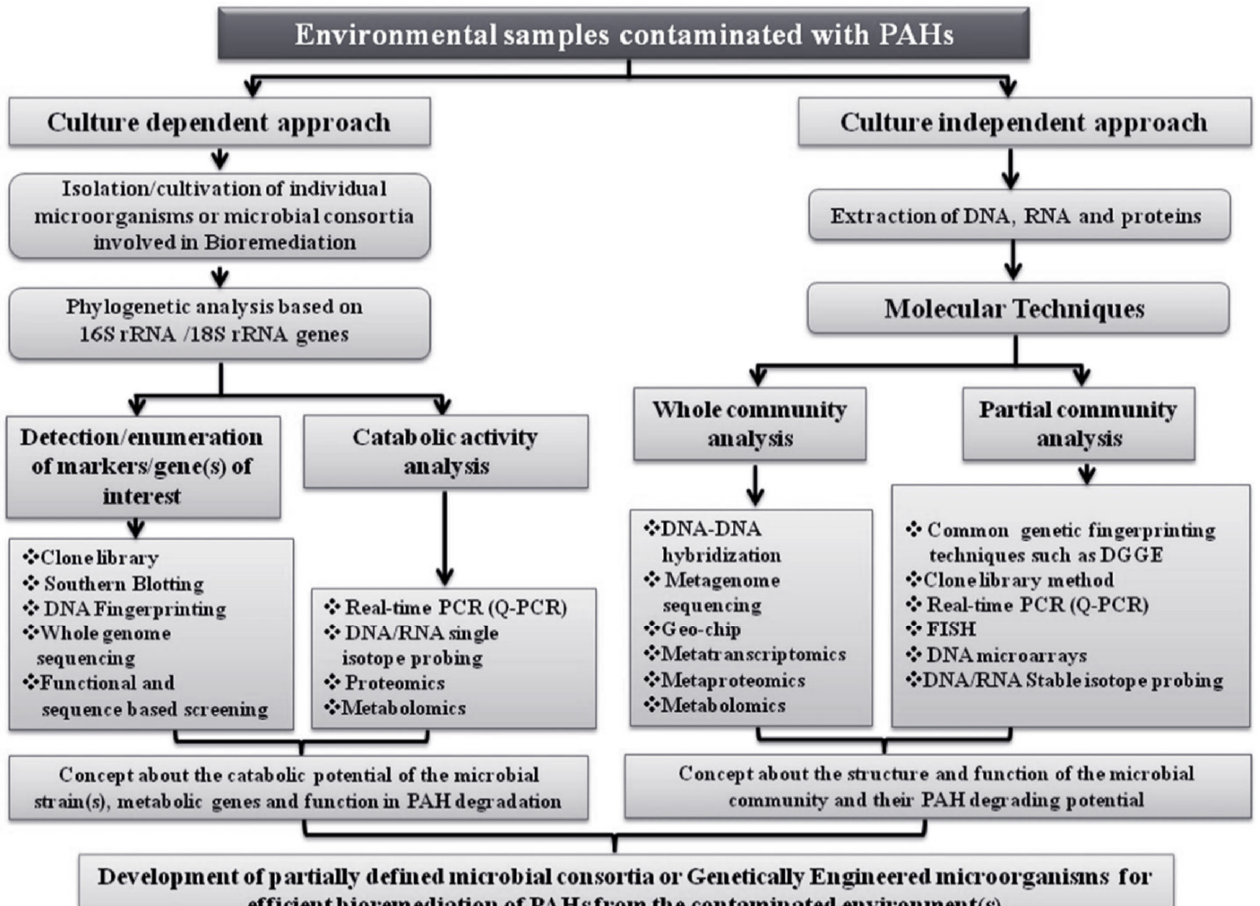
Figure 4. The future path for a better knowledge of microbial PAHs is outlined by a summary of several molecular approaches [58].